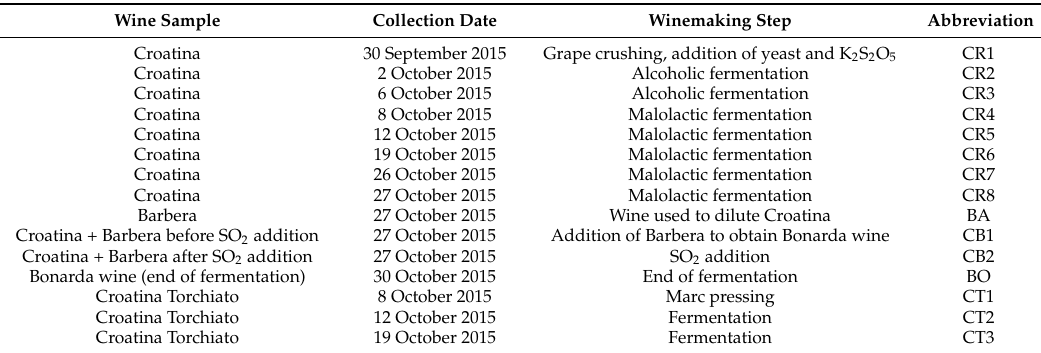
Table 1. List of wine samples, their collection date, step of winemaking process and abbreviation used in this